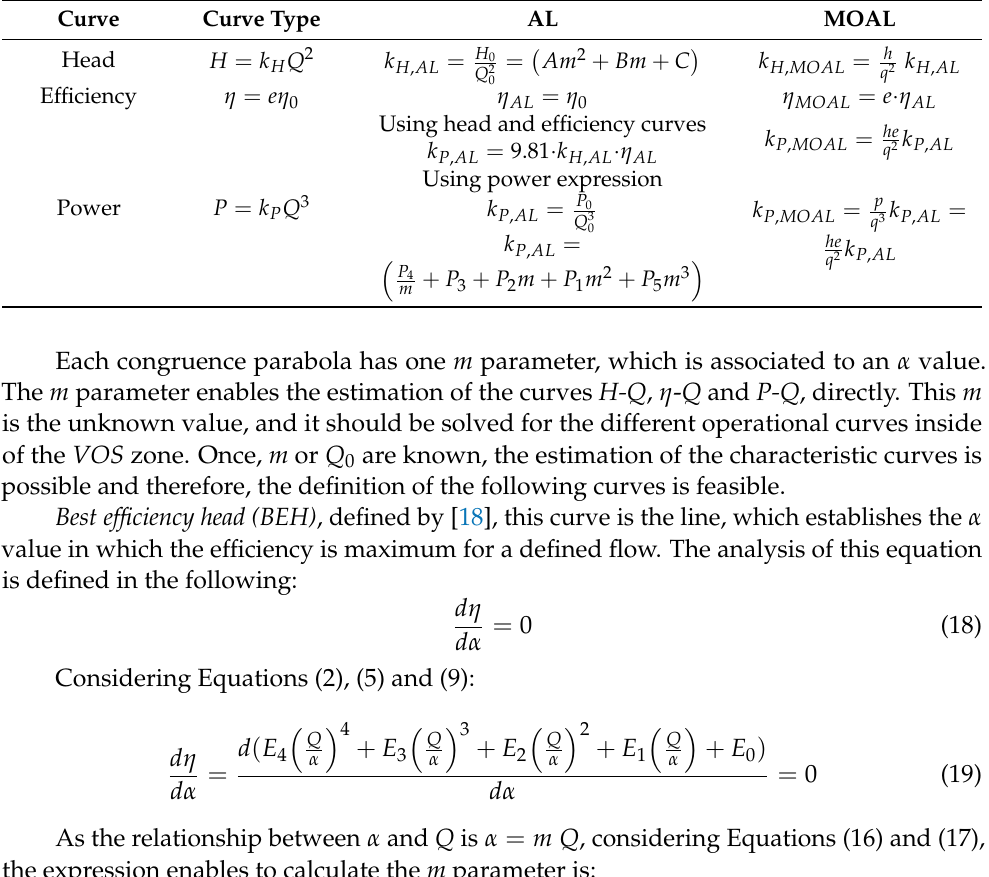
Table 1. Definition of the curves as a function of k i parameter.